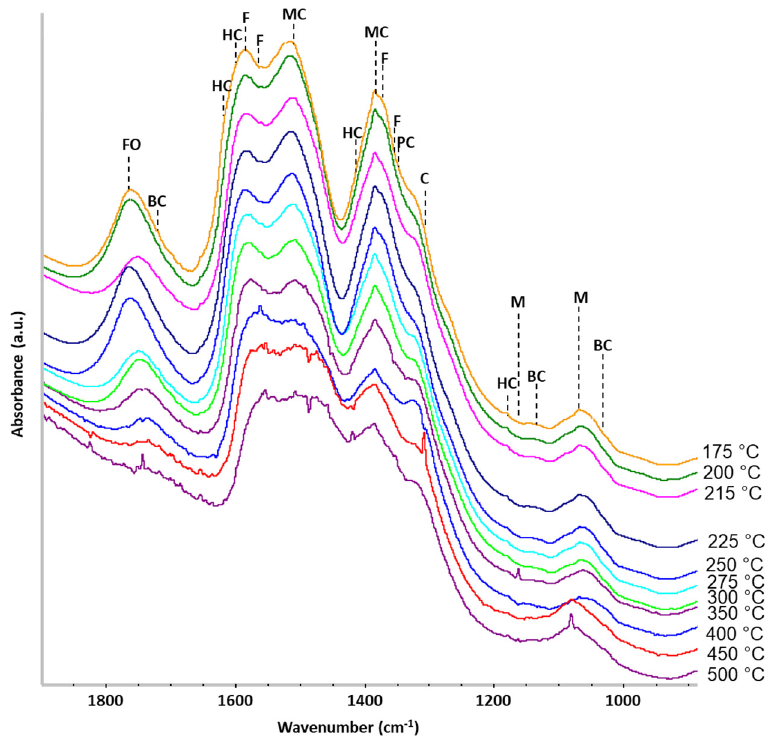
Figure 8. Operando FTIR spectra for CO 2 methanation over the Ni/Ce catalyst. Species identification: HC (hydrogen carbonate), MC (monodentate carbonate), BC (bidentate carbonate), PC (polydentate carbonate), F (formate), M (methoxy), FO (formaldehyde), C (carboxylate).